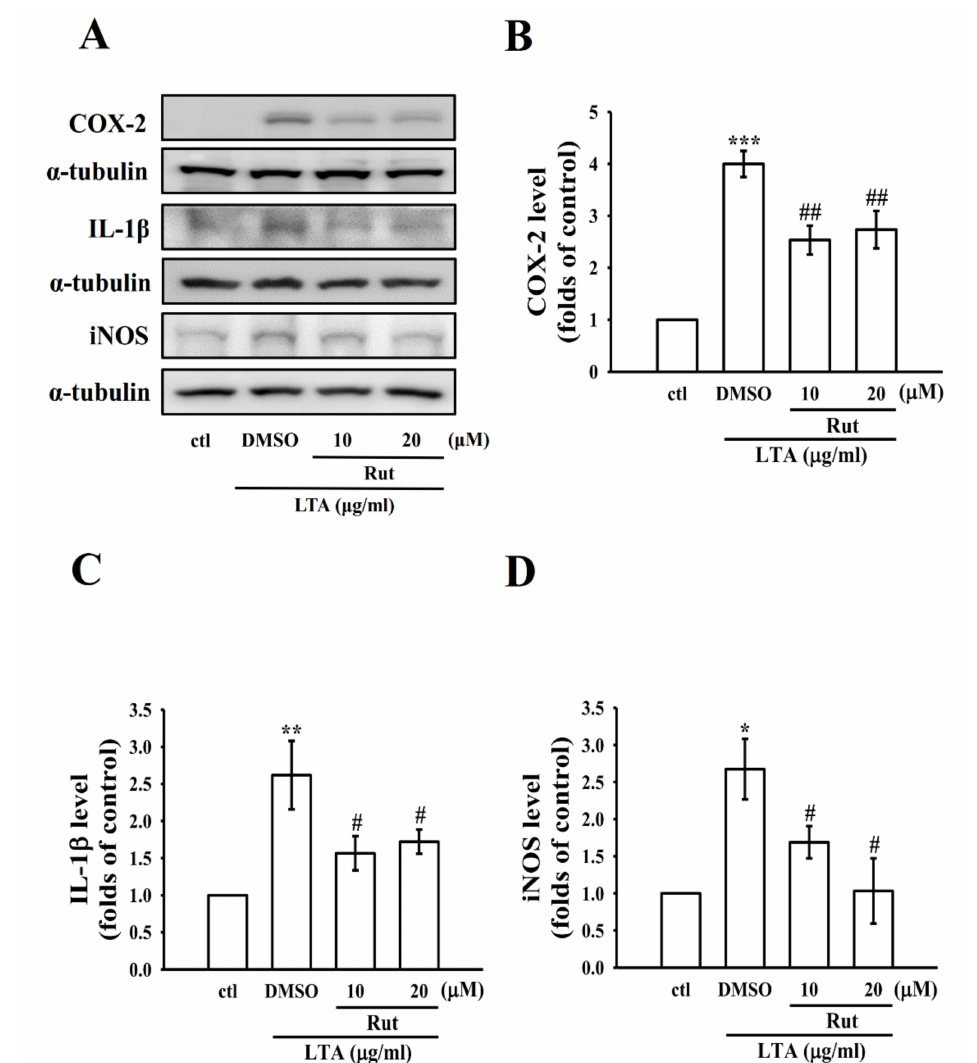
Figure 2. Effects of Rut on the expression of cyclooxygenase-2 (COX-2), interleukin-1 beta (IL-1 β ), and inducible nitric oxide synthase (iNOS) in LTA-stimulated RAW cells. ( A – D ) Cells were pretreated with Rut (10 and 20 µ M) for 20 min and then stimulated by LTA (10 µ g/mL) for 24 h. The levels of ( B ) COX-2 ( C ) IL-1 β and ( D ) iNOS protein expression were evaluated as described in the Methods section. Data are presented as the means ± SEM ( n = 4); * p < 0.05, ** p < 0.01, and *** p < 0.001, compared with the control group; # p < 0.05 and ## p < 0.01, compared with the LTA